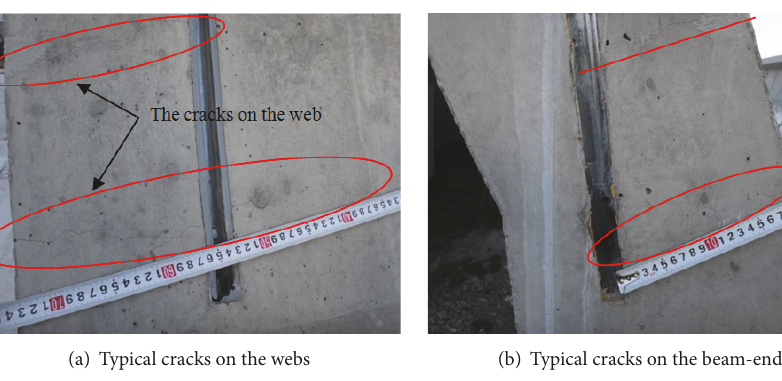
Figure 5: The cracks at the joint areas of the web and beam-end.